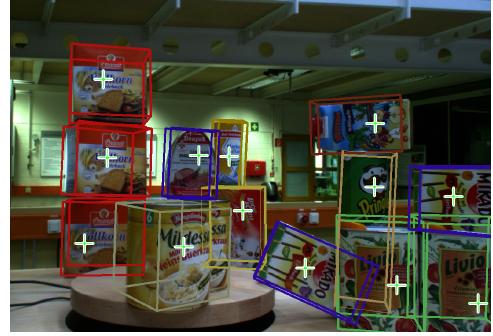
Figure 6. Exemplary result for object recognition (unique colour and bounding box for each object).